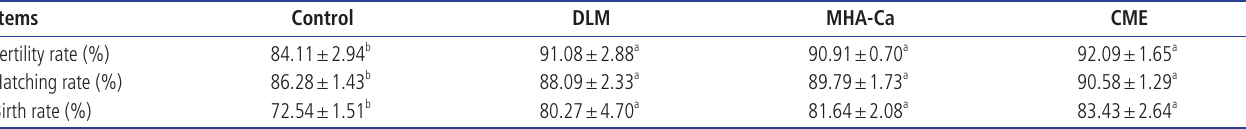
Table 3. Effects of different methionine sources on reproduction performance of broiler breeders